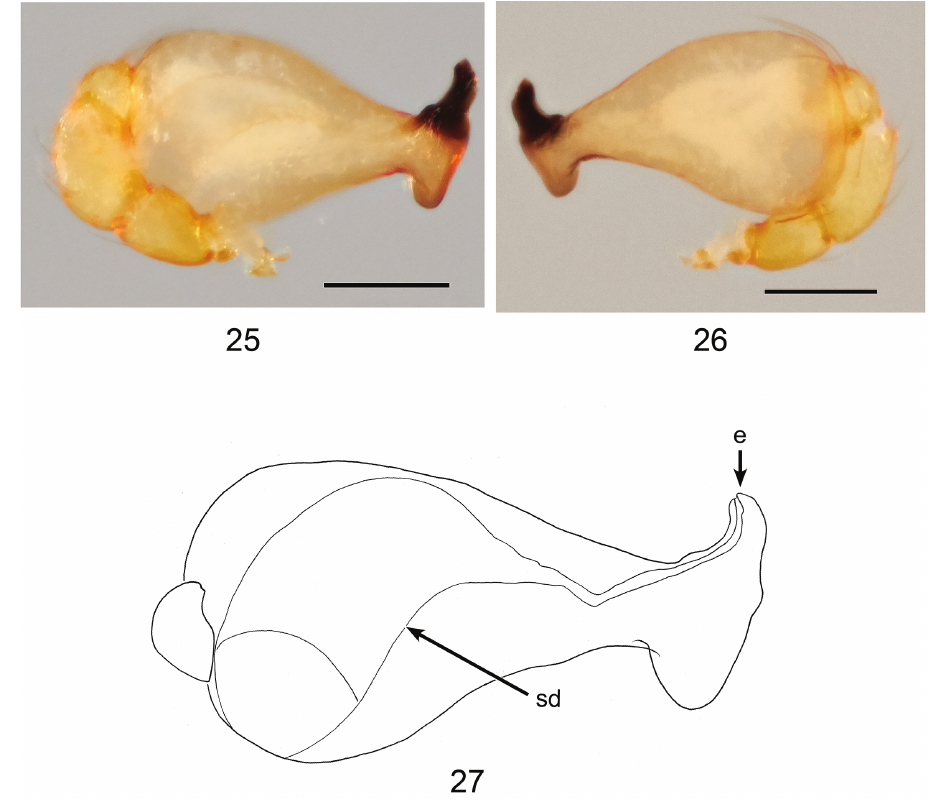
Figures 25–27. Ablemma kelinci sp. n., male. 25 Palp, prolateral view. 26 Palp, retrolateral view. 27 Schematic illustration of palpal bulb retrolateral view. Scale bar: 0.1